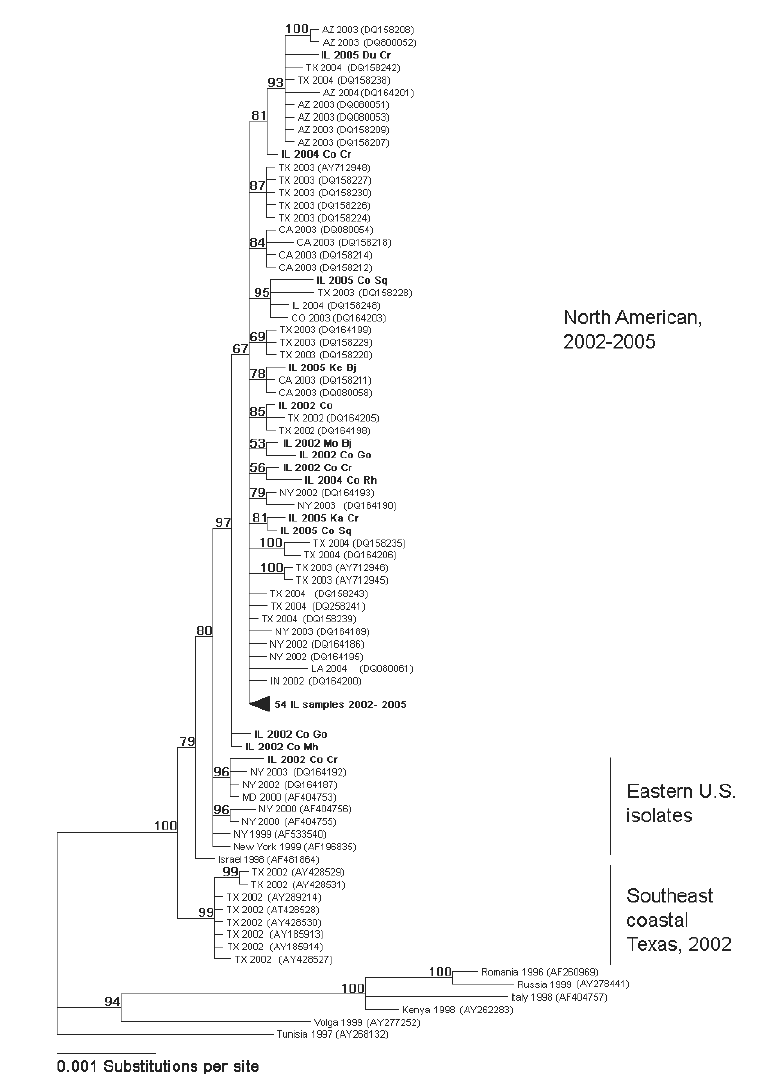
Figure 2 – Phylogenetic tree constructed by Bayesian analysis of 132 WNV envelope gene